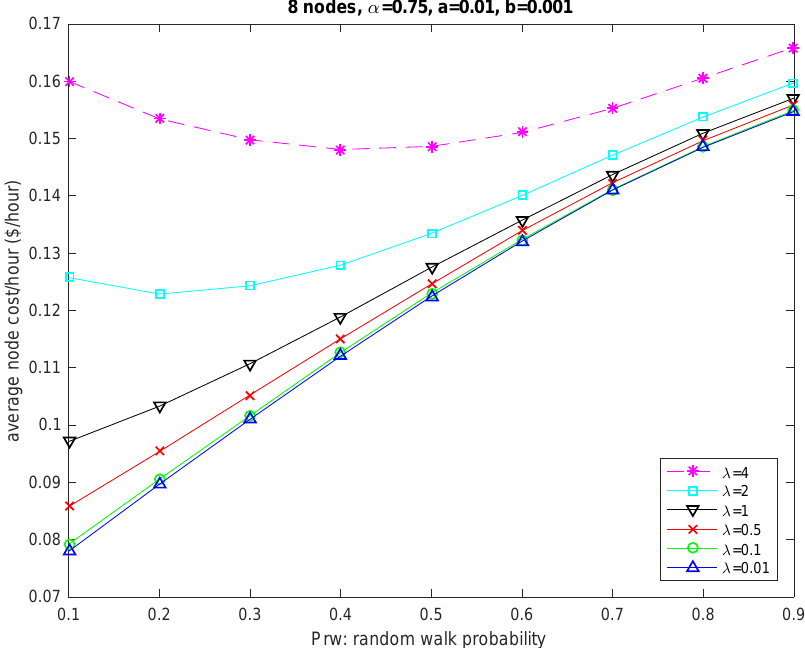
Figure 4. Impact of pure random decisions P rw